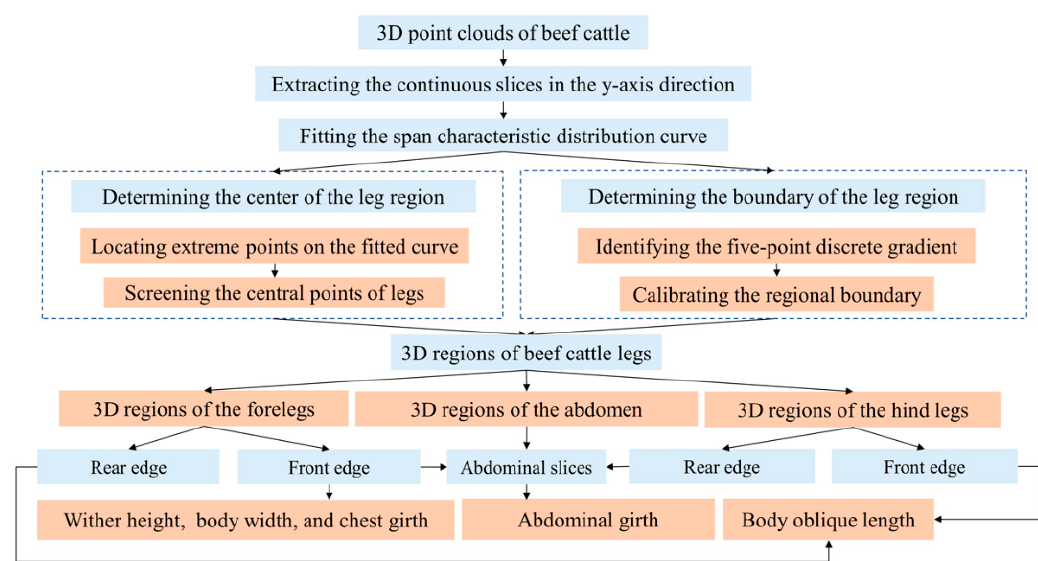
Figure 3. A schematic showing the detailed process for beef cattle body dimension measurement.